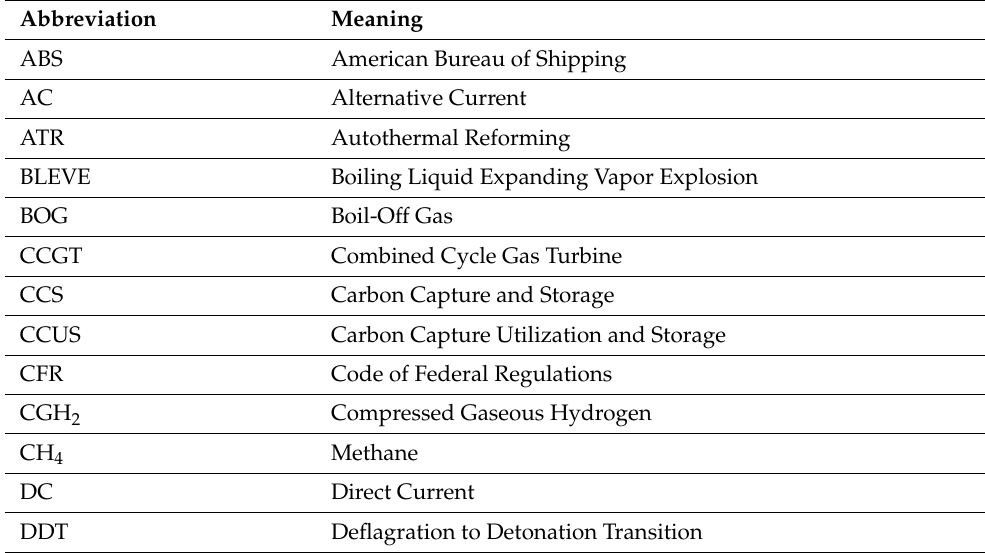
Table 1. List of all the abbreviations used in the